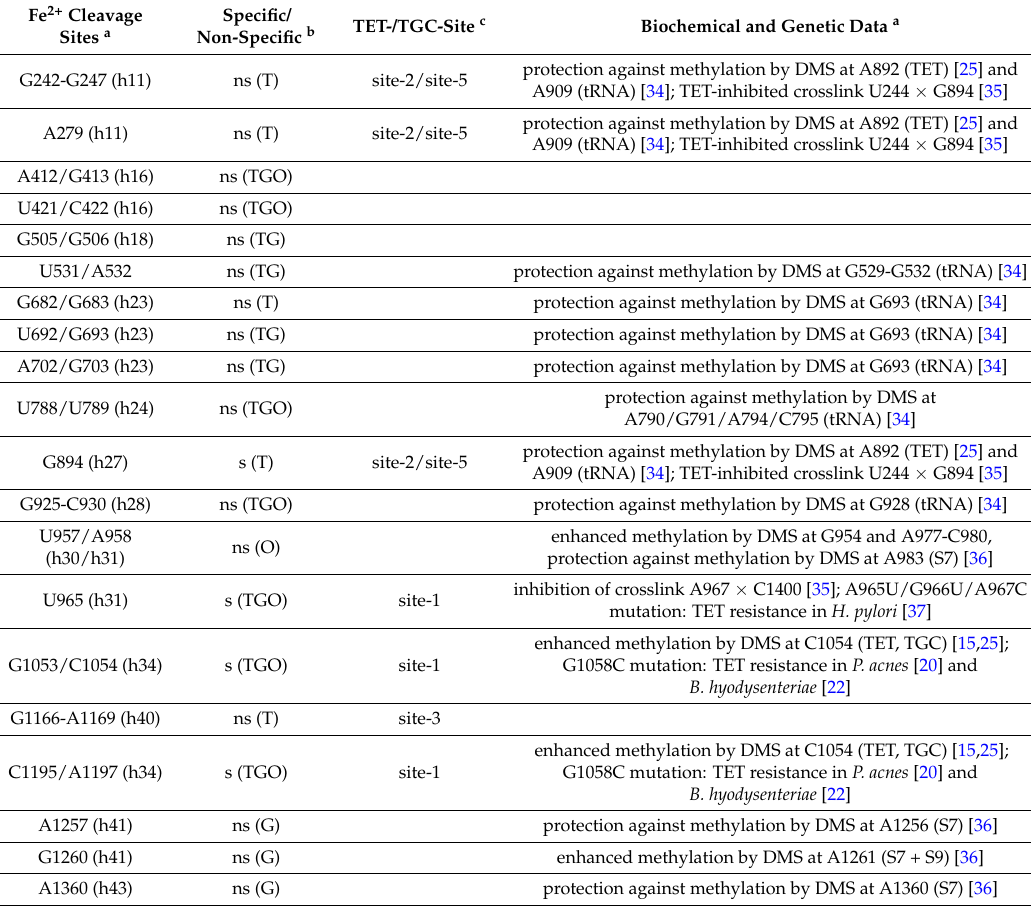
Table 2. Fe 2+ -mediated and TET-, TGC- or OMC-directed cleavage sites on the 16S rRNA and the corresponding biochemical crystallography and genetic